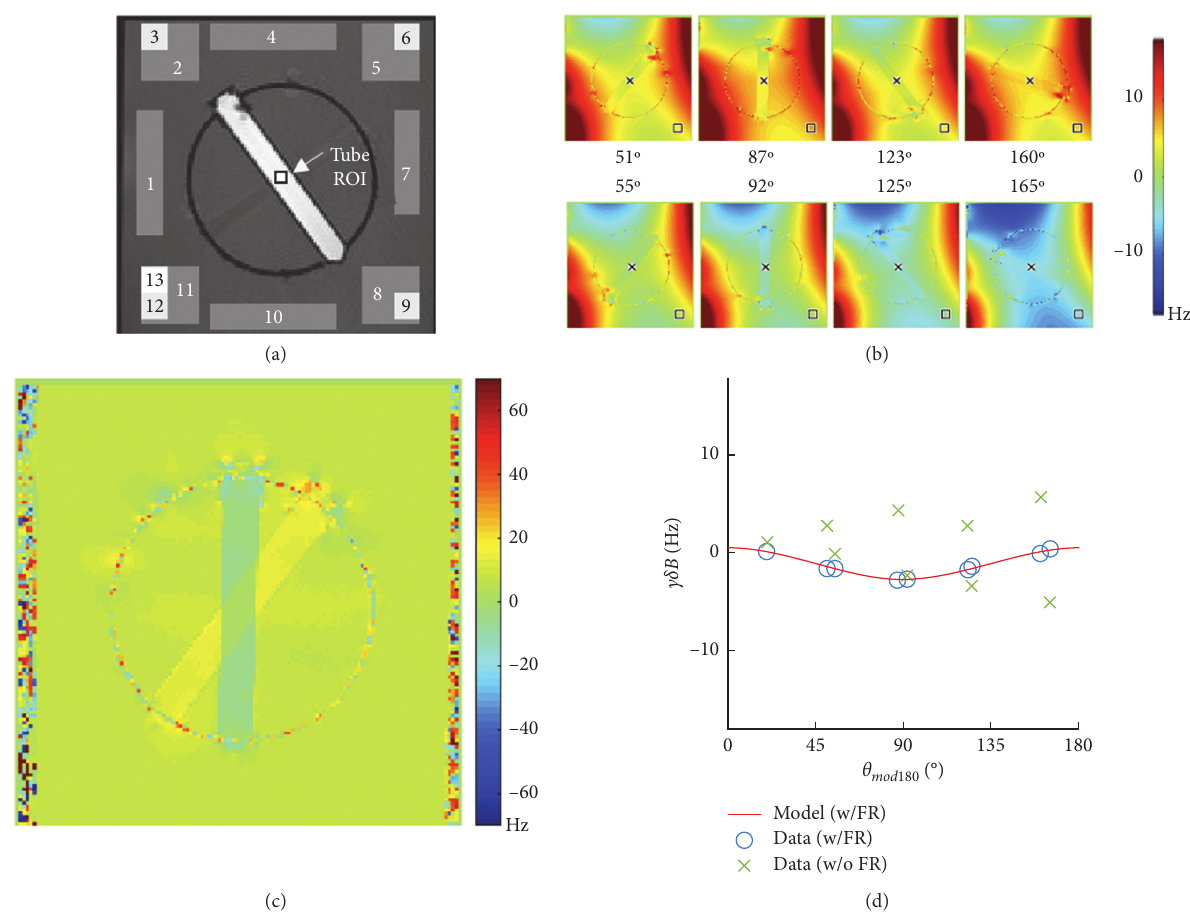
Figure 2: (a) An example magnitude GRE image showing both the tube ROI (small black box in center) used for the analysis and the placement of the 13 background ROIs. (b) Example frequency images in tube 3 (0.5mM GdCl3) obtained with the single GRE sequence (1mm, TR 45 ms) and reconstructed with MEDI.RG phase estimation method. (c) Also using SEGE+MEDI.RG, the field difference ( r , θ ) − δ B ( r , θ ) ) showing that this difference is attributable to the spatially invariant component (in between two angles ( δ B total 2 total 1 homogeneous areas) and a spatially variant component (in areas close to material boundaries). The spatially invariant component of the field difference is removed with frequency referencing (FR). (d) A plot of the frequency against the angle of rotation (modulo 180 ° ) is shown for each of the data without frequency referencing (in green ( x ), data after frequency referencing using the frequency reference ROI #9 (blue circles), and the model’s prediction of the frequency (solid red